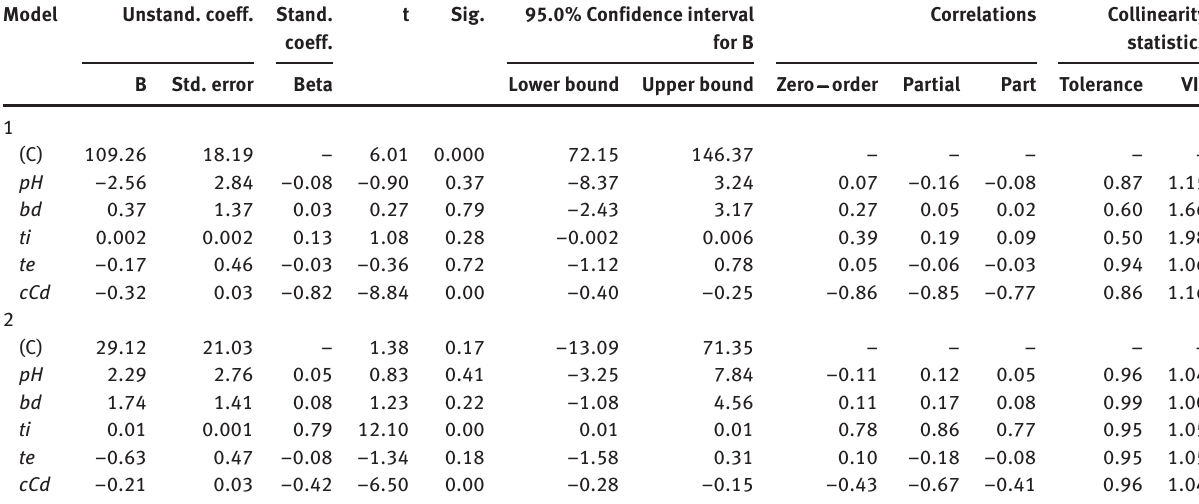
Table 6: Coefficients of the determined